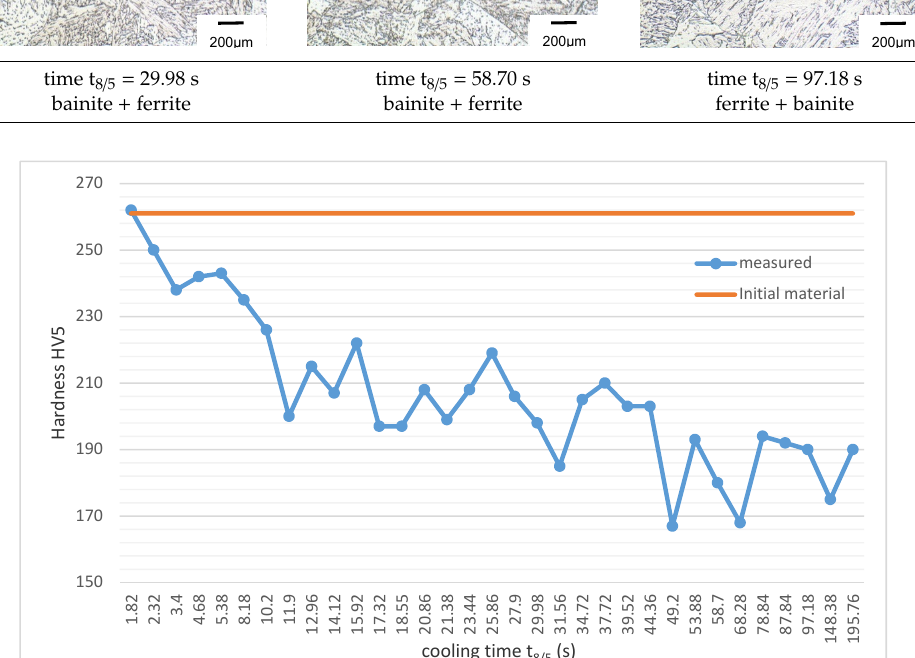
Figure 14. The results of hardness HV5 measurements in thermo-mechanically simulated HAZ areas of S700MC steel.